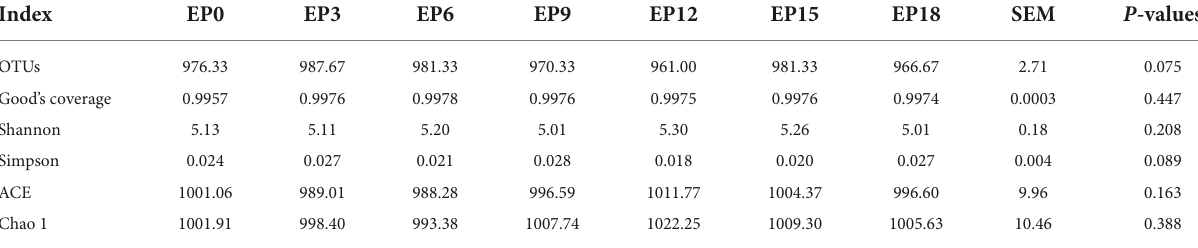
TABLE 7 Numbers of OTUs and alpha diversity index of the intestinal microbiota in hybrid groupers fed with